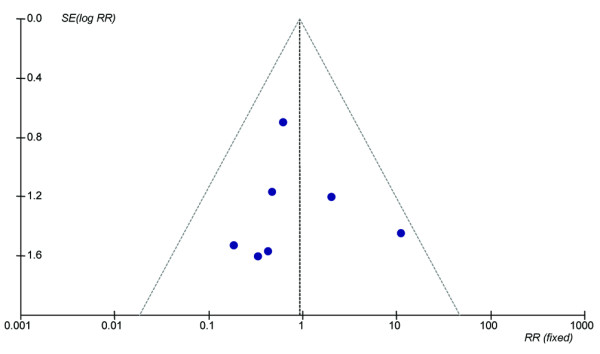
Funnel plot showing the possibility of a small publication bias. RR, relative risk; SE, standard error.